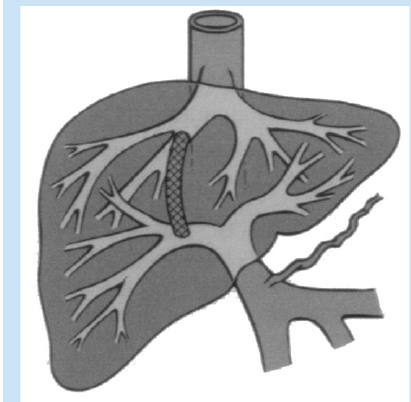
Fig. 1a. Diagramatic representation of the TIPS shunt with stenting of the tract created between the portal and hepatic veins.